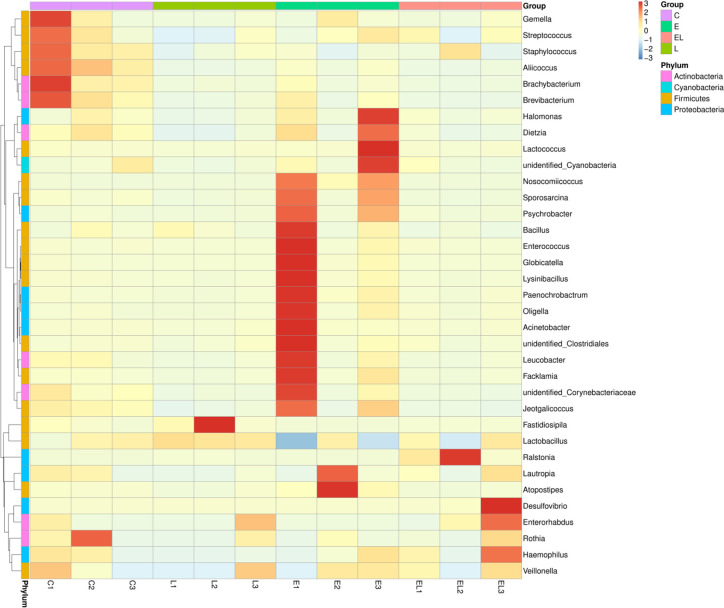
Heatmap of the relative abundance of bacterial communities at the genus level in each sample. Each color-block in the heatmap indicates the relative abundance of a bacterial genus in a sample.